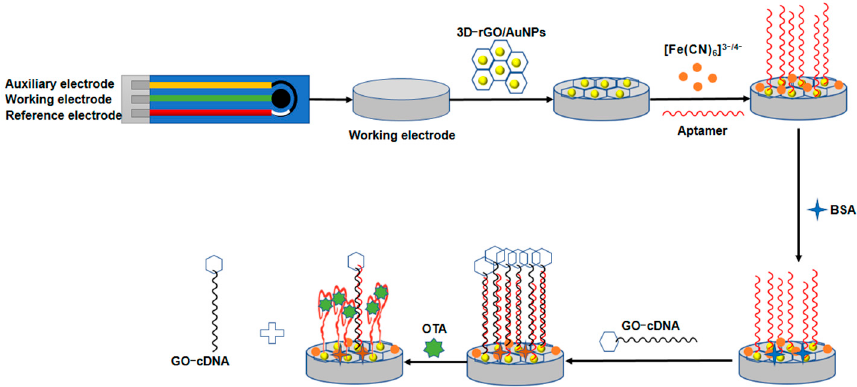
Figure 1. Schematic illustration of the presented aptasensor for OTA detection.